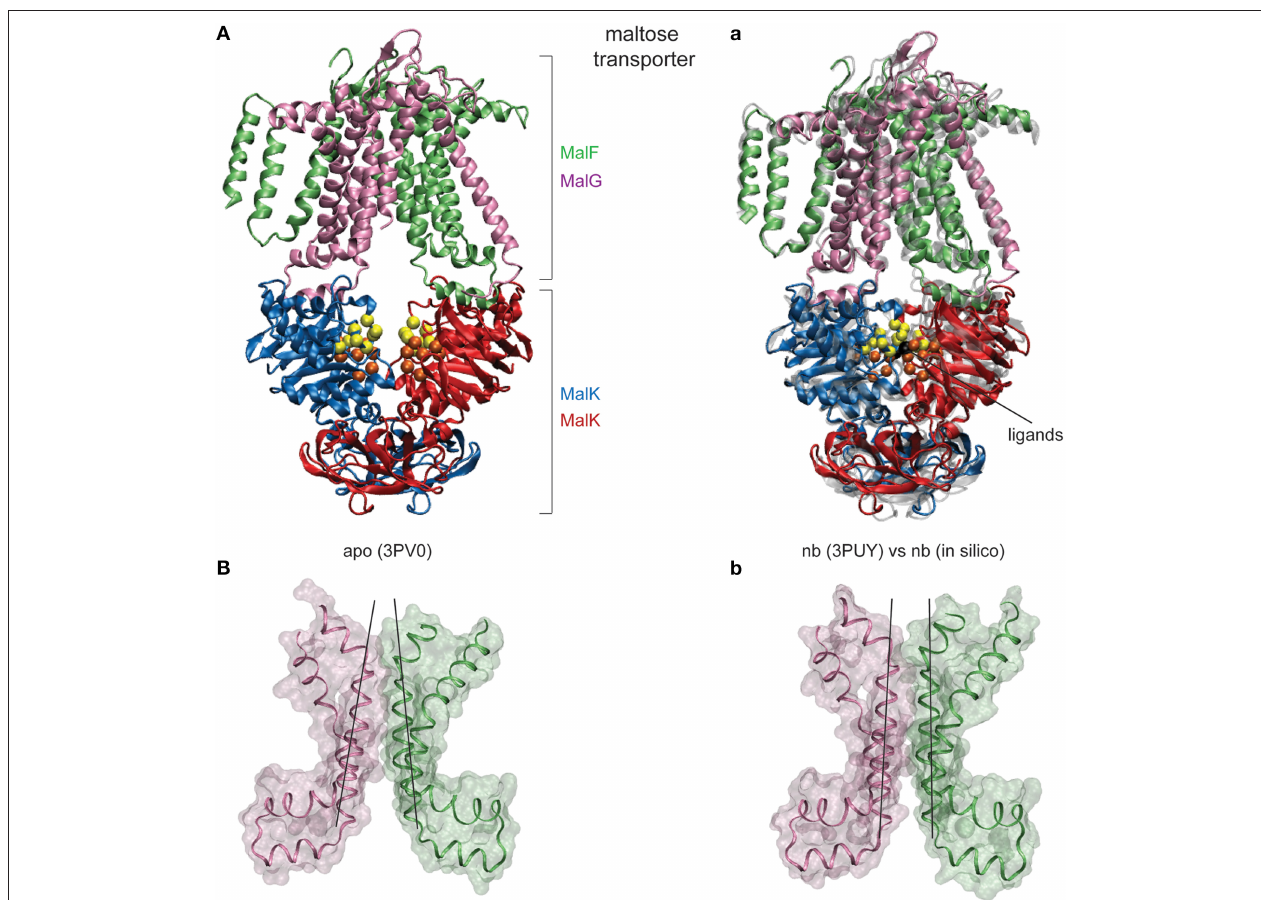
FIGURE 4 | Nucleotide-induced conformational changes in the MalFGK 2 maltose transporter. (A) The apo crystal structure shown in ribbon representation with chains colored differently. Conserved motifs inside the NBDs are colored as in Figure 2 . (a) Comparison of modeling results and the AMP-PNP bound crystal structure. A single ligand-complexed conformation obtained after modeling of nucleotide binding (in solid coloring) is superimposed with the AMP-PNP complexed experimental structure (in transparent gray). The two bound ligands are shown as black beads. (B,b) Structure of the transmembrane maltose binding site and the coupling helices in the apo state and the ligand-complexed in silico conformation. Only two helices from each TMD are displayed as ribbons together with the surface representation (chain F: Asp364-Asn449 and chainG: Thr158-Arg238). Black lines have been aligned to the central helices to emphasize the correctly obtained progression from the inward-facing to the outward-facing TMD